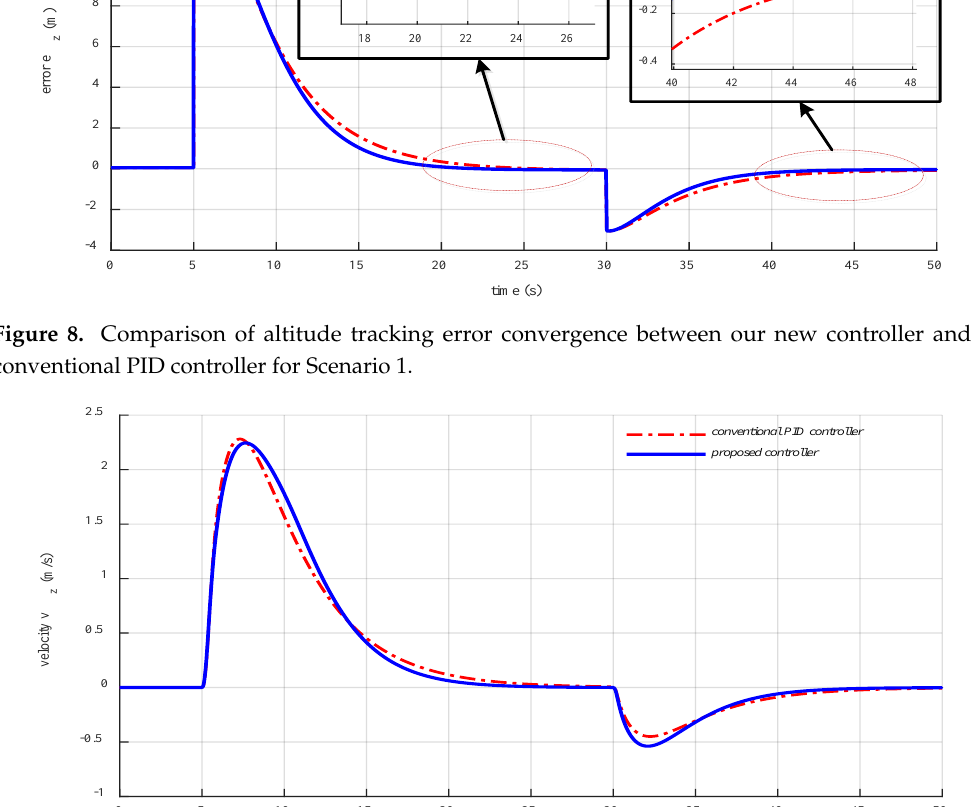
Figure 10. Comparison of the vertical acceleration performance between our new controller and a conventional PID controller for Scenario 1. Figure 11. Comparison of the control signal,